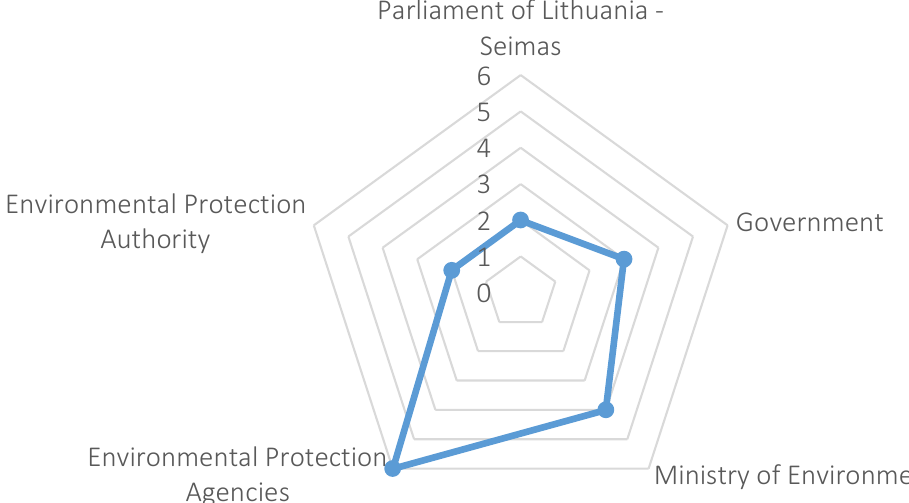
Figure 1. Capacity of civil participation in the activities of national public governance institutions of environmental protection in the field of municipal waste